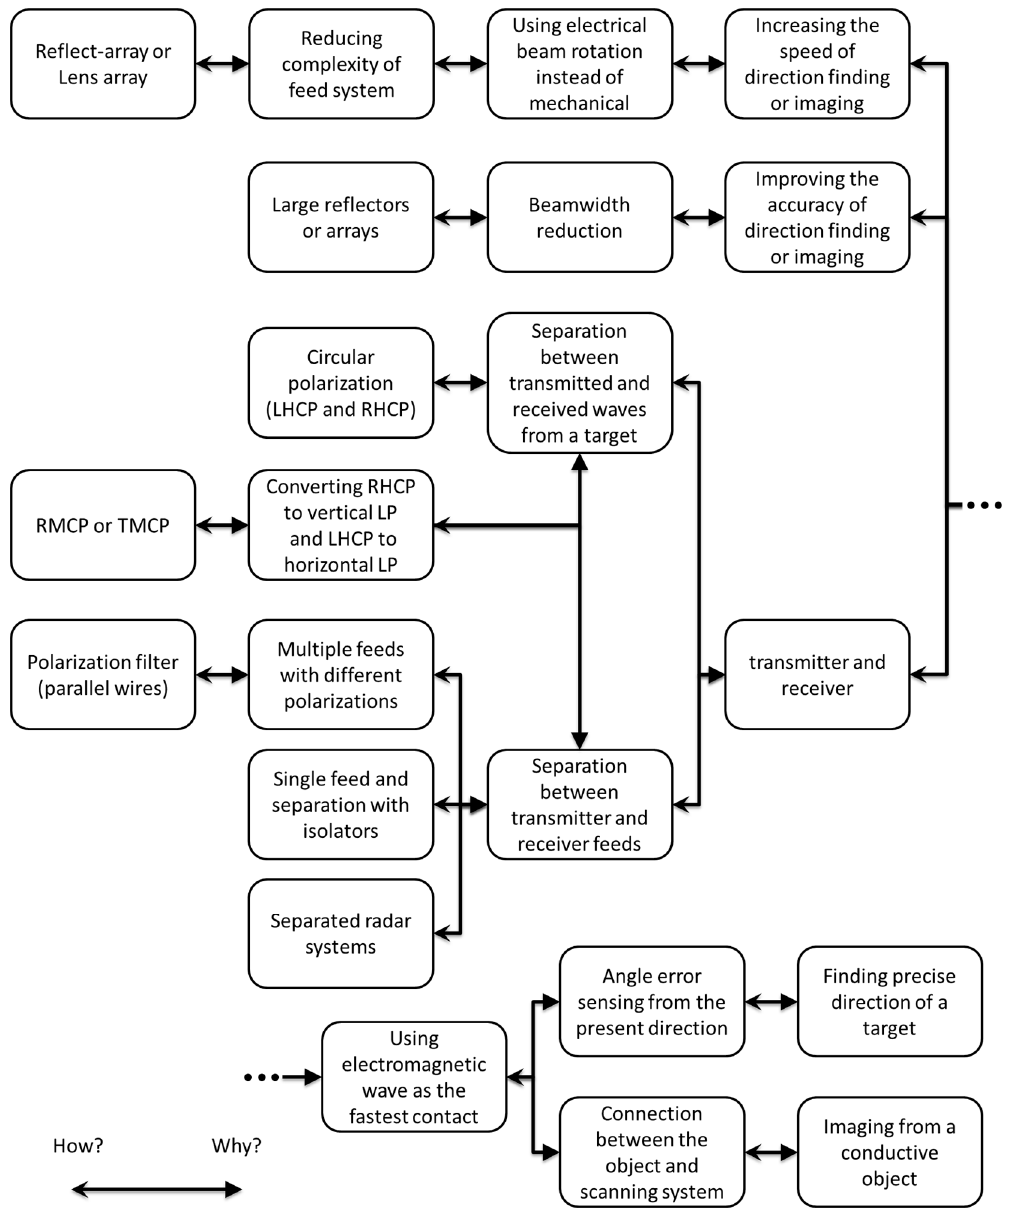
Figure 5. Function Analysis (FA) diagram for direction finding or radio-wave imaging systems.